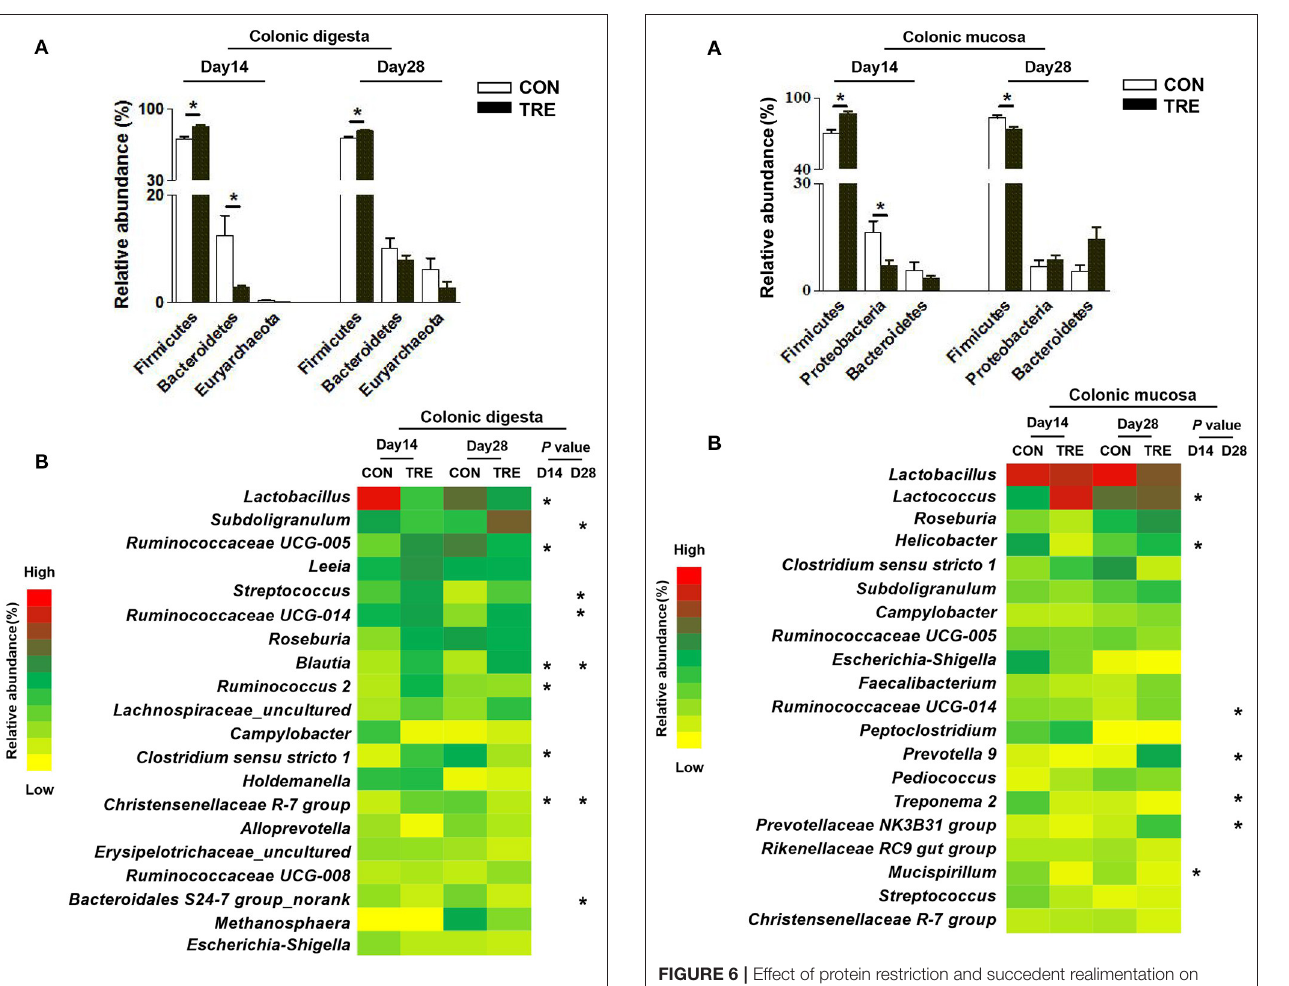
FIGURE 5 | Effect of protein restriction and succedent realimentation on bacterial composition of colonic digesta in weaned piglets ( n = 6). (A) Alterations of dominant phyla in colonic digesta on day 14 and 28. (B) Alterations of dominant genera in colonic digesta on day 14 and 28. p < 0.05 were considered significant and markers (*) between groups on the same day. CON, control group; TRE, treatment group.